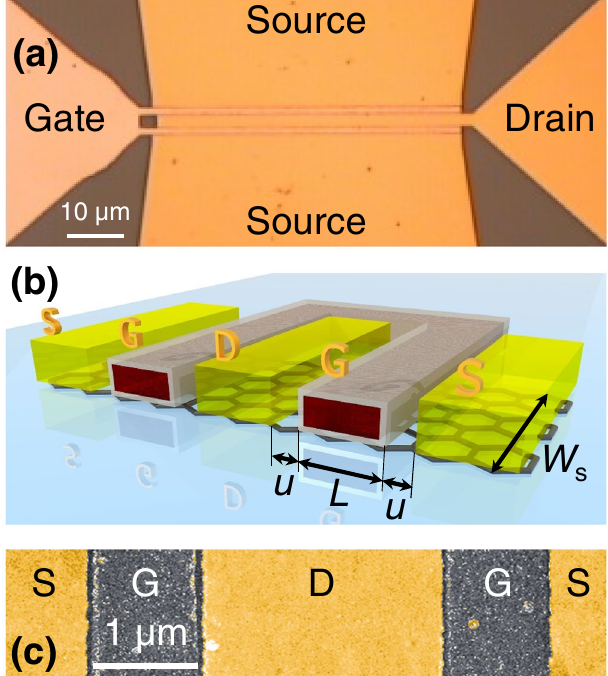
Figure 1. High-frequency GFET. ( a ) Optical image of one of the fabricated GFETs with the gate length L = 1.1 μ m. Graphene stripe cannot be seen as it is completely covered by the contacts. ( b ) Schematic of the central part of the GFET. Source (S) and drain (D) contacts (Au; yellow) are separated by an underlap (length u ) from the gate (G) contact (Al; red core), which is covered by an insulating layer (AlOx; gray shell). Width of graphene stripes W was 5, 20 and 50 μ m. All GFETs had the same contact width (~50 μ m) regardless of the s stripe width. The channel width = W W 2 . ( c ) Scanning electron microscopy image of the central part of one the s fabricated GFETs with the gate length L = 1 μ m. The underlap is = u 100